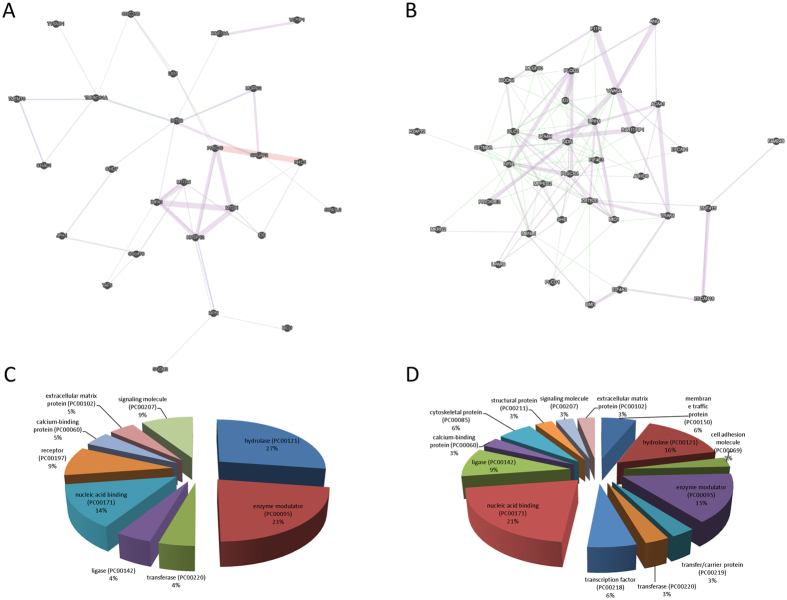
(A) Functional network of the significant upregulated genes obtained from the meta-analysis of GSE73652, GSE44295 and GSE22138; (B) Functional network of the significant downregulated genes obtained from the meta-analysis of GSE73652, GSE44295 and GSE22138; (C) Protein class analysis for the significant upregulated genes obtained from the meta-analysis of GSE73652, GSE44295 and GSE22138; (D) Protein class analysis for the significant downregulated genes obtained from the meta-analysis of GSE73652, GSE44295 and GSE22138.